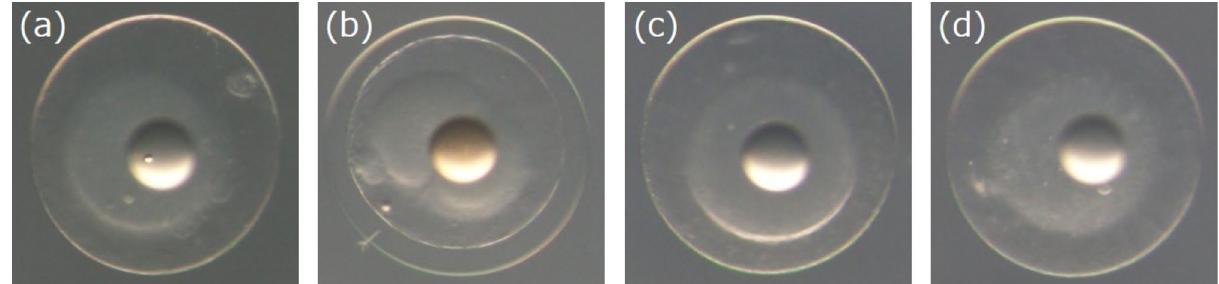
Figure 6. Test image examples to compare the prediction accuracy of experts with the network. ( a , b ) Actually NH. The network predicted them correctly while four experts failed. ( c ) Actually not NH. The network and only one expert predicted correctly. ( d ) Actually not NH. The network failed to predict, and three experts predicted